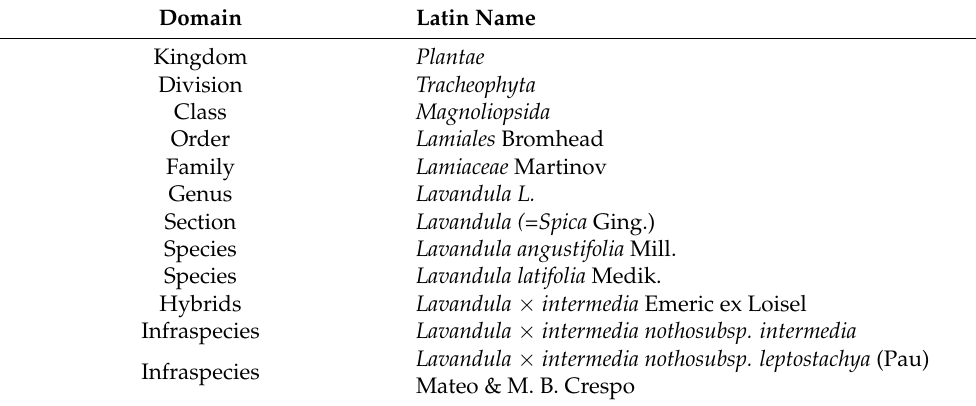
Table 1. The classification of Lavandula × intermedia Emeric ex Loisel